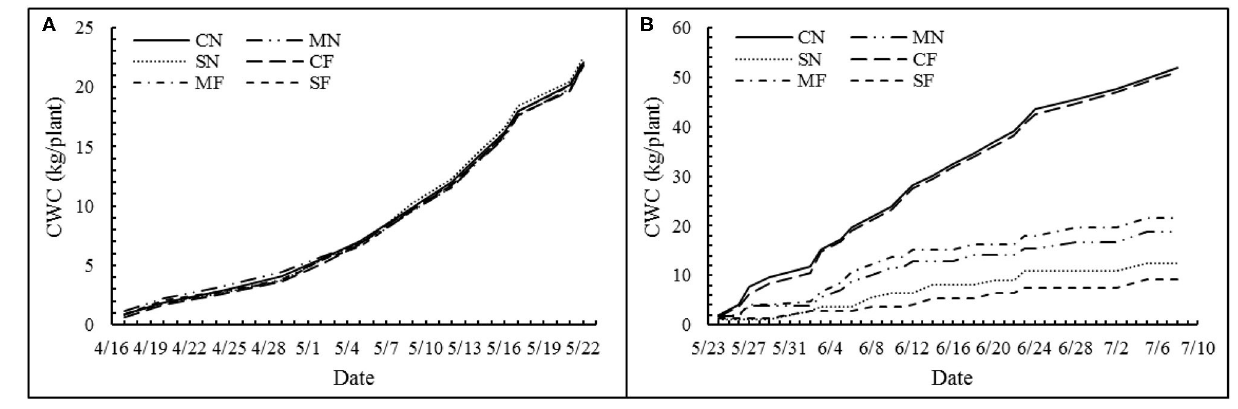
FIGURE 2 | Cumulative water consumption (CWC) of each treatment before (A) and after (B) salinity